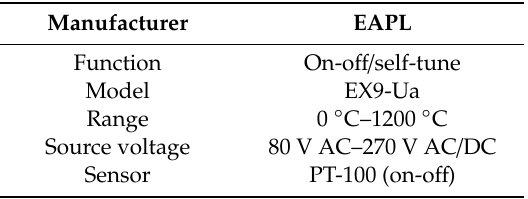
Table 1. Details of temperature